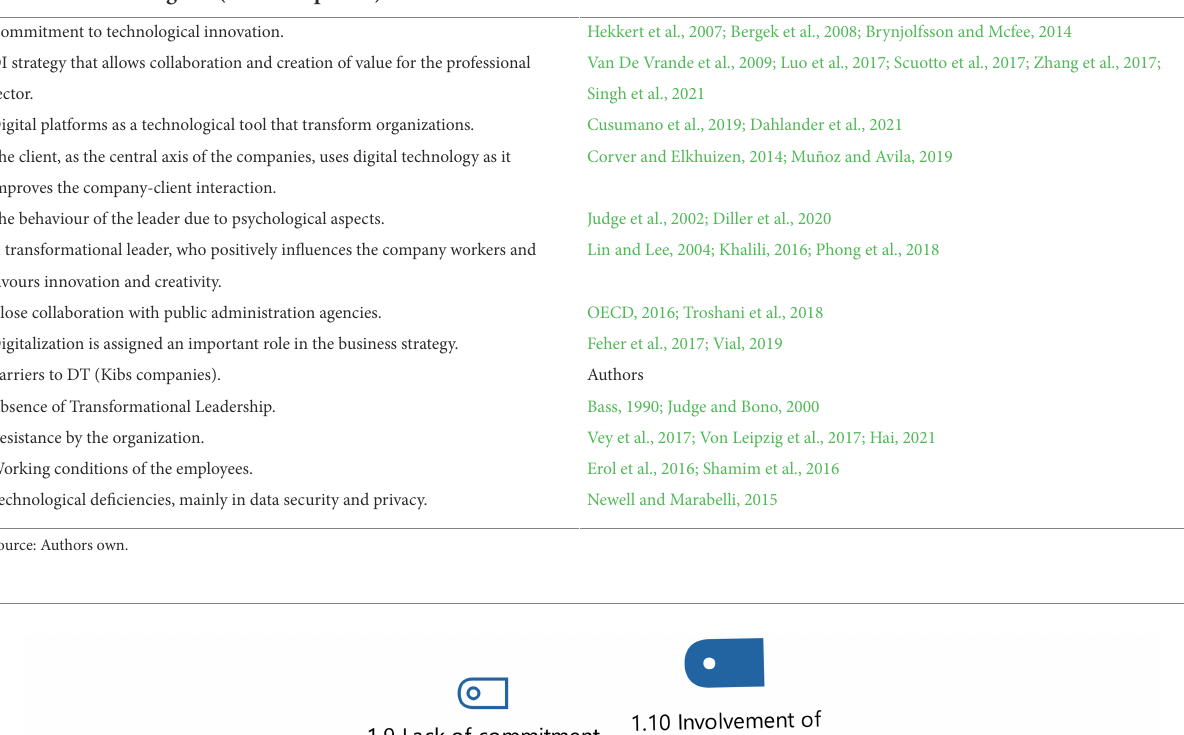
TABLE 7 Properties of DT from the qualitative analysis and associated with the scientific literature. Measures benefiting DT (Kibs companies).